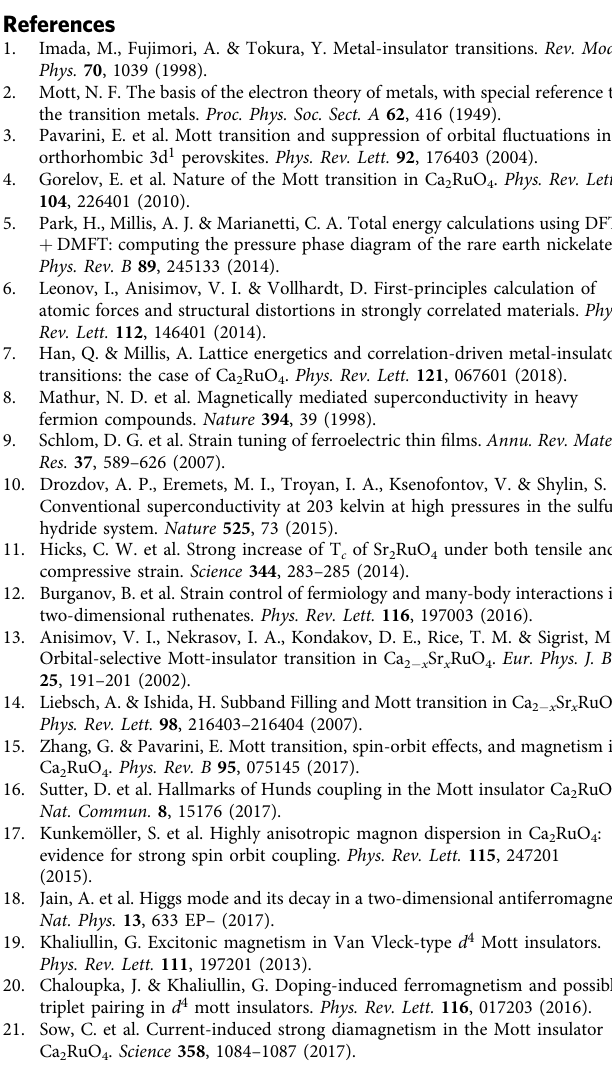
enhanced SOC. Due to the lack of structural data from strained Ca 2 − x Pr x RuO 4 , we used the ground state L-Pbca crystal structure of Ca 1.89 La 0.11 RuO 4 reported in Supplementary Table 2. The doping of x = 0.11 was included in the DMFT part of this calculation, while the DFT step was done for stoichiometric Ca 2 RuO 4 . Reducing the doping to x = 0.04 in the metallic phase has a minor effect on the DMFT self-energies only. The Fermi surface shown in Fig. 2c was computed with the orbitally diagonal self-energy from a DMFT computation without spin-orbit coupling and the frequency independent orbitally off-diagonal elements from the calculation with